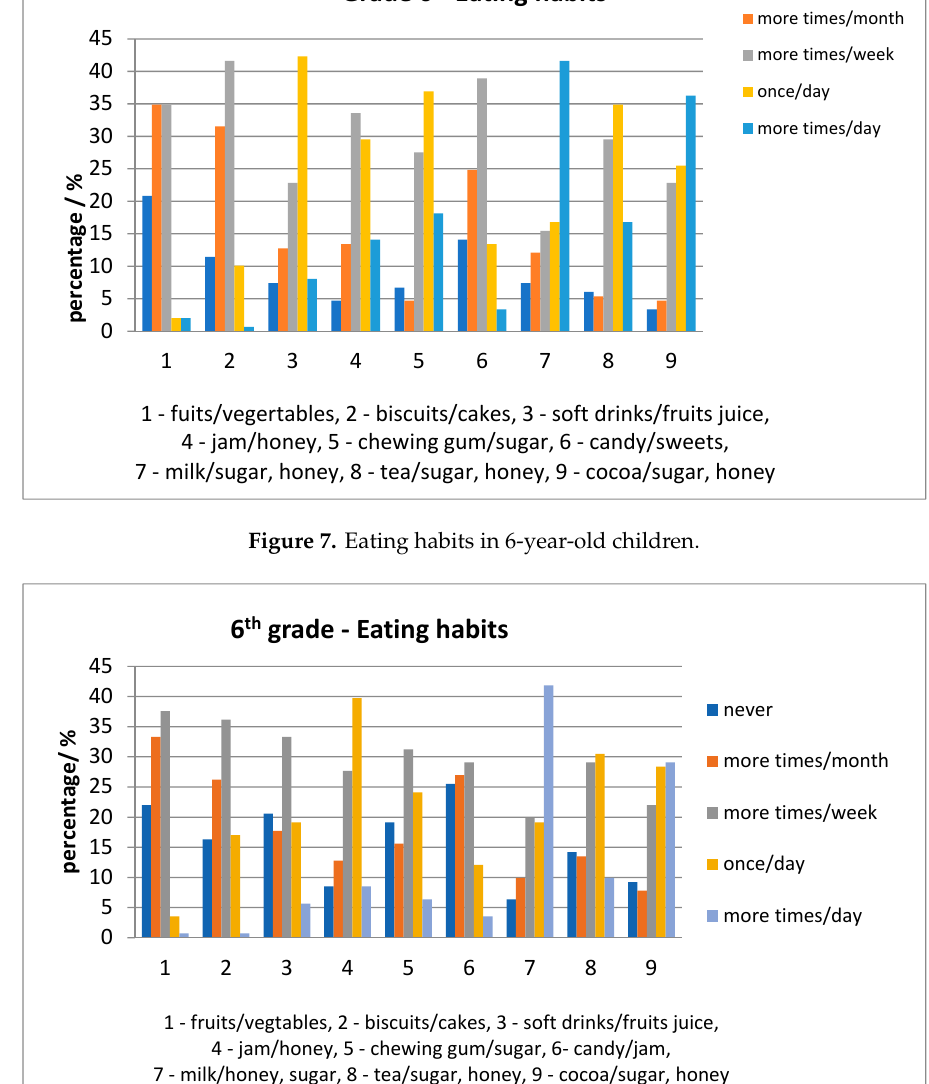
Figure 8. Eating habits in 12-year-old children.